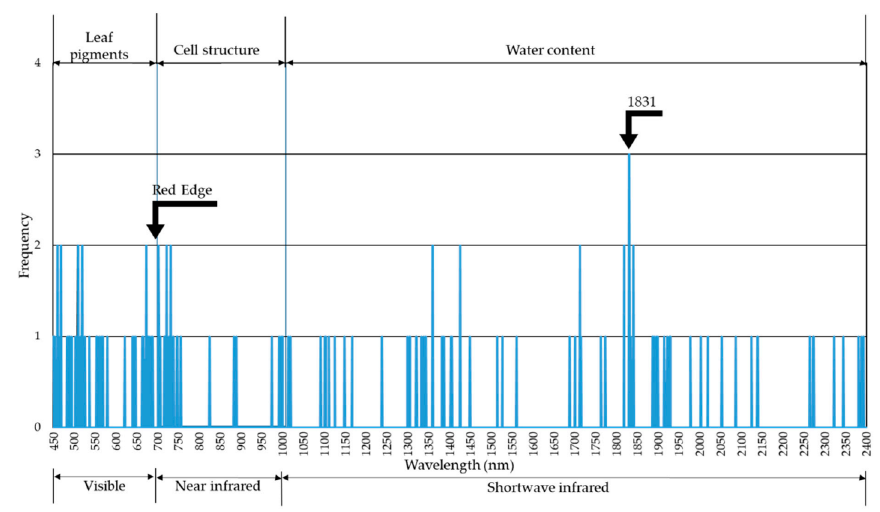
Figure 1. Frequency of appearance of individual bands (wavelengths) in the eight discriminant